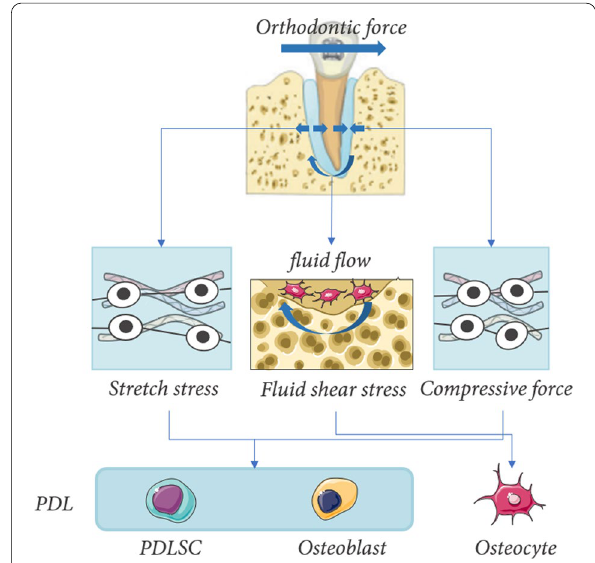
Fig. 2 The mechanical transfer of orthodontic force and corresponding effector cells. During OTM, the side to which the orthodontic force is directed is subject to significant compressive stress, whereas the opposite side is subject to strong stretch stress. Meanwhile, as bone canaliculus are compressed and narrowed, the fluid in the bone flows from the compression side to the stretch side [16]